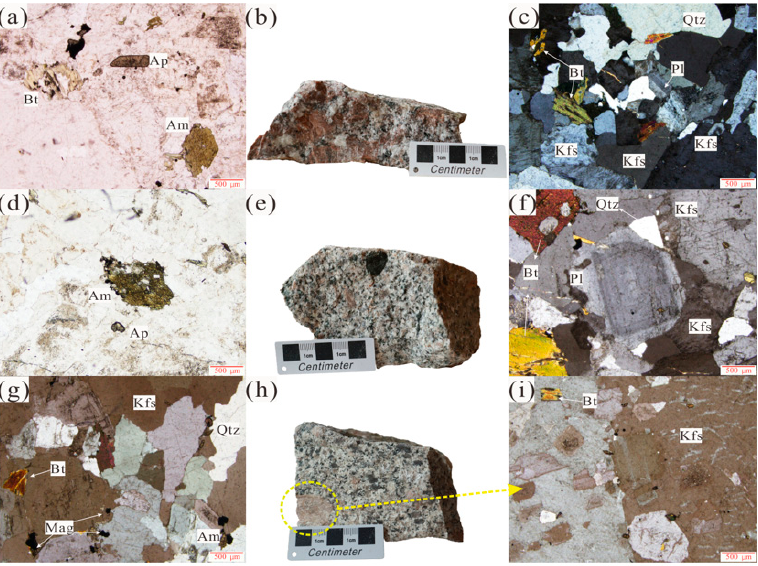
Figure 3. Representative field photographs and photomicrographs (single and crossed polars) of